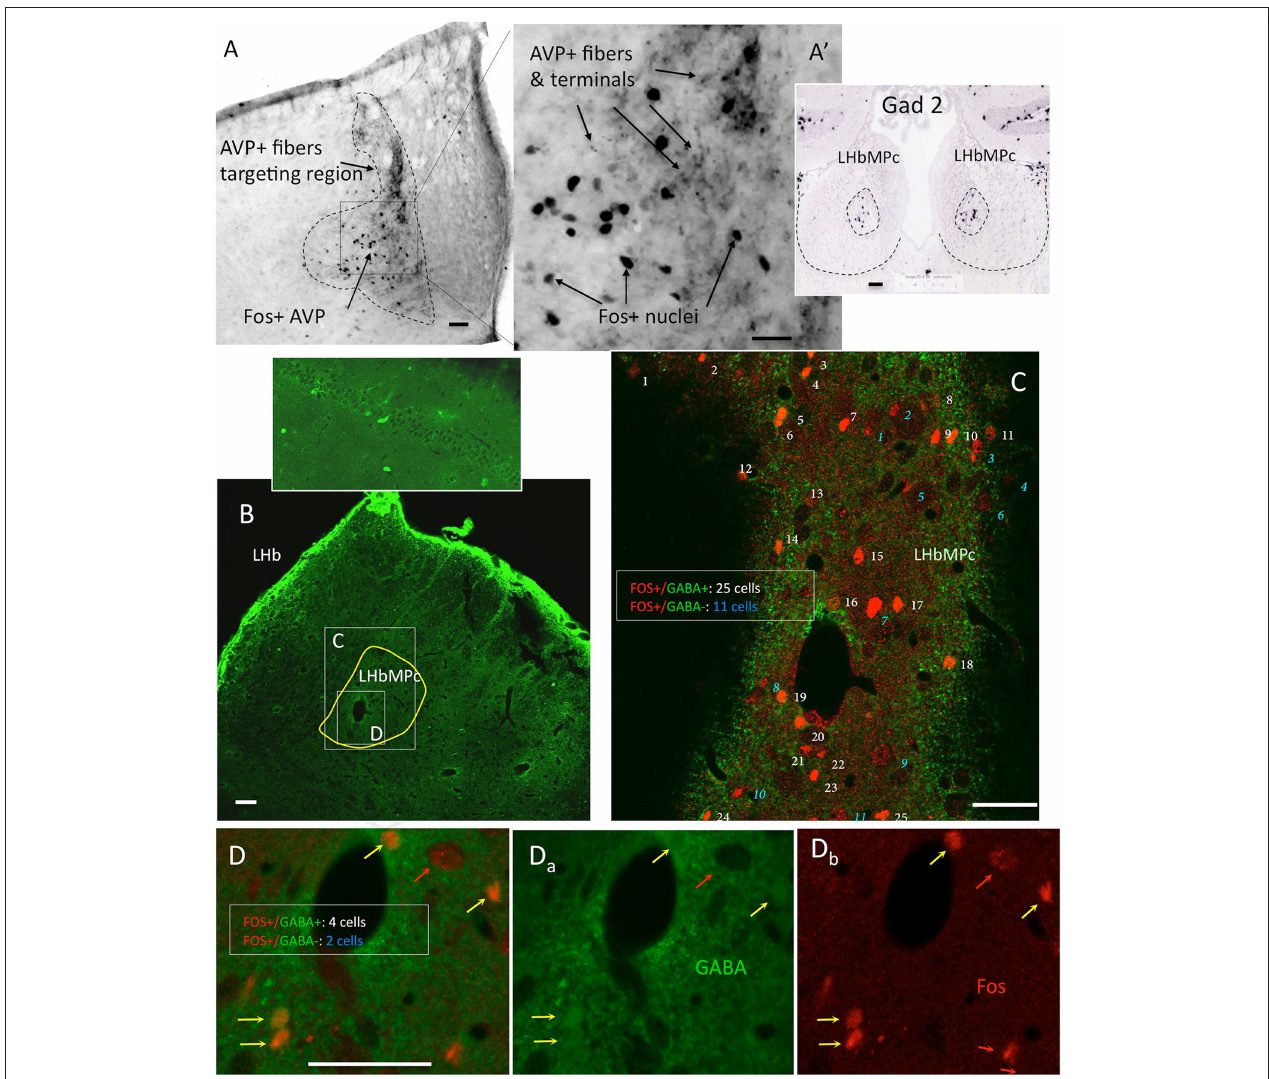
FIGURE 5 | Twenty-four hours of water deprivation induced strong Fos expression in LHbMC; most of the activated neurons were GABA immunopositive. (A). WD24 produced a spatial pattern of neuronal activation which coincided with AVP+ fiber distribution, i. e. the medial central nucleus of the lateral habenula LHbMC. Inset shows Gad2 in situ hybridization pattern in LHbMC (obtained from the Allen Institute for Brain Science (http://mouse.brain-map.org/ experiment/show/79591669). Panels (B–D) confocal images for coronal sections of habenula with double immunofluorescence showing that most of the Fos+ cells were GABA + neurons. White consecutive numbers and yellow arrows indicate Fos + /GABA + neurons, whereas blue consecutive numbers indicate Fos + /GABA- neurons. Panels (D a-b ) show the magnified squared region of (B) , where 6 Fos + nuclei are found, 4 of them had GABA + cytoplasms (yellow arrows) and 2 had GABA negative cytoplasms (red arrows). Scale bar: 50 µ m.